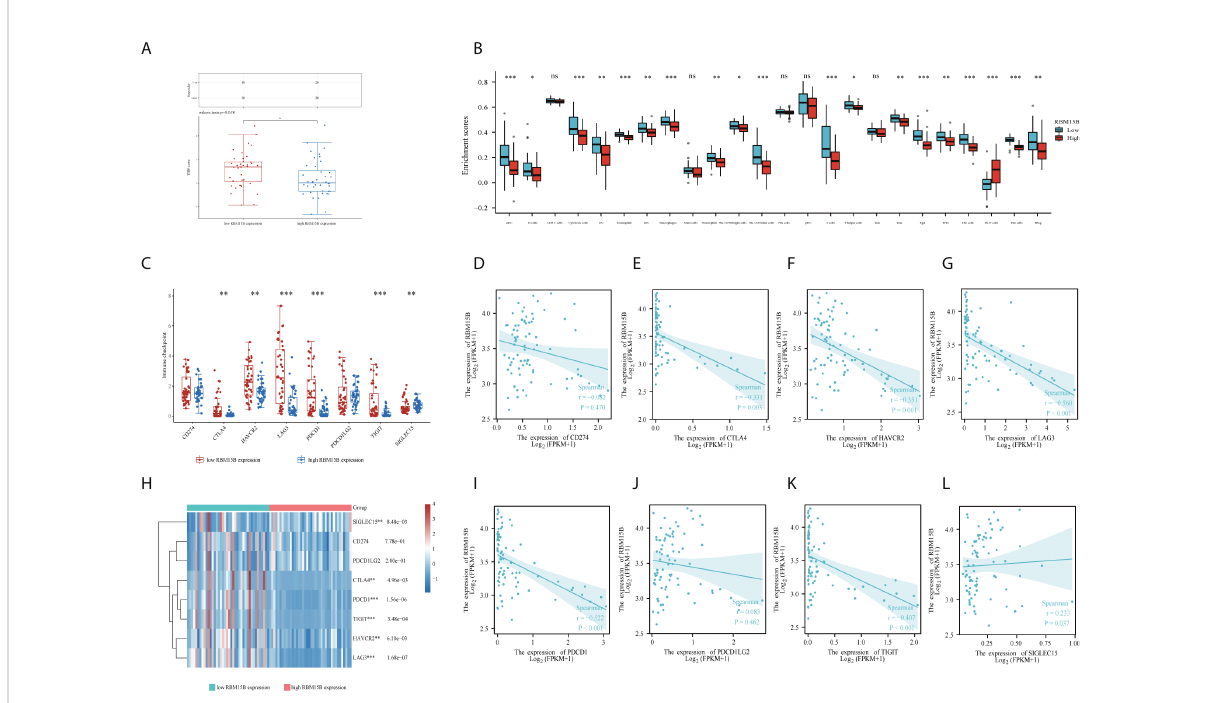
FIGURE 5 Function and pathway enrichment analysis of RBM15B and CD8(+) immune in fi ltrations in uveal melanoma cases. (A) distribution of immune response scores between high and low RBM15B expression groups in uveal melanoma. (B) Immune cell in fi ltration between low and high expression of RBM15B groups. (C) Expression distribution of immune checkpoints gene between low and high expression of RBM15B groups. Spearman correlation of RBM15B with expression of (D) CD274; (E) CTLA4; (F) HAVCR2; (G) LAG3 in UM. (H) Heatmap of immune checkpoints gene expression. The different colors represent the trend of gene expression in different samples. Spearman correlation of RBM15B with expression of (I) PDCD1; (J) PDCD1LG2; (K) TIGIT; (L) SIGLEC15 in UM. *p<0.05, **p<0.01, ***p<0.001. ns, no signi fi